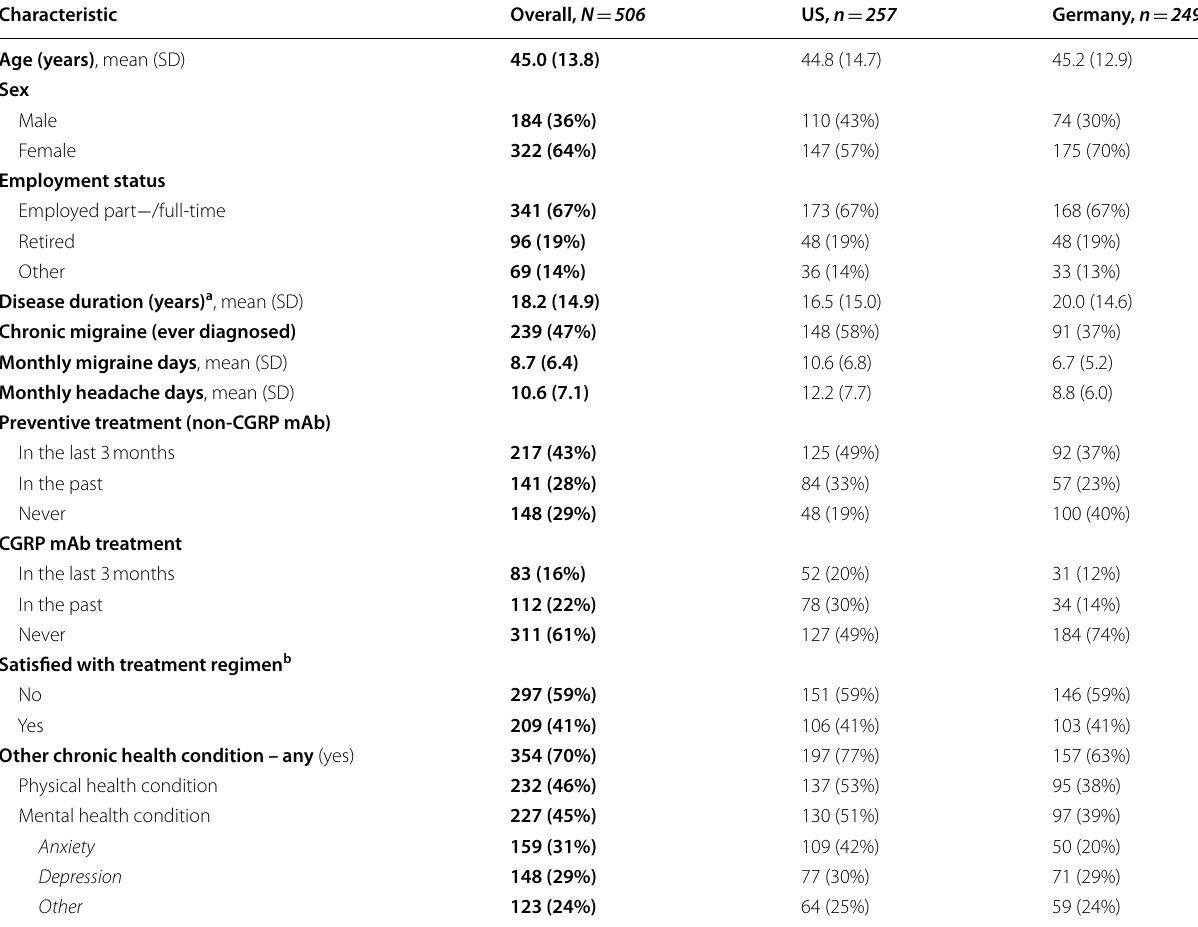
Table 1 Patient demographic and clinical